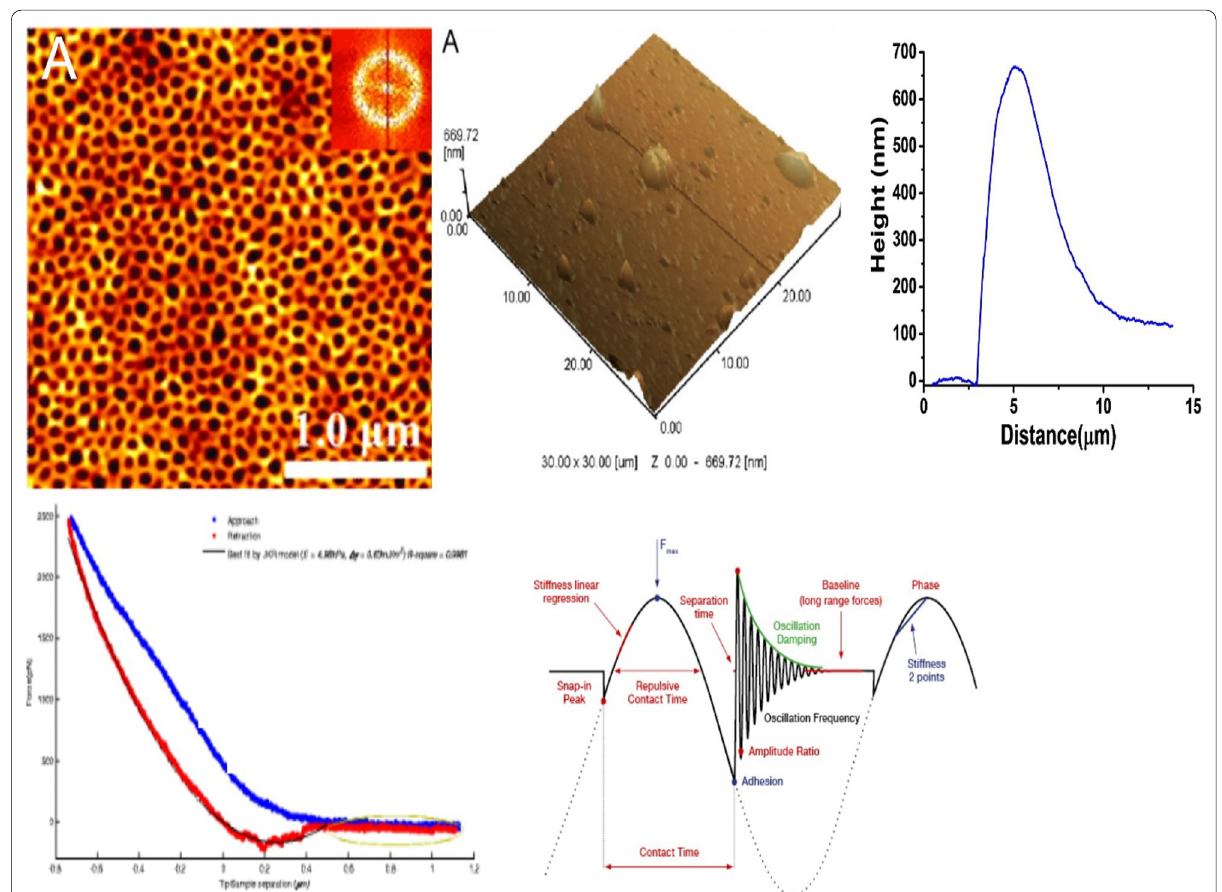
Fig. 6 AFM showing the compactness of its molecules, its topography, and mechanical properties